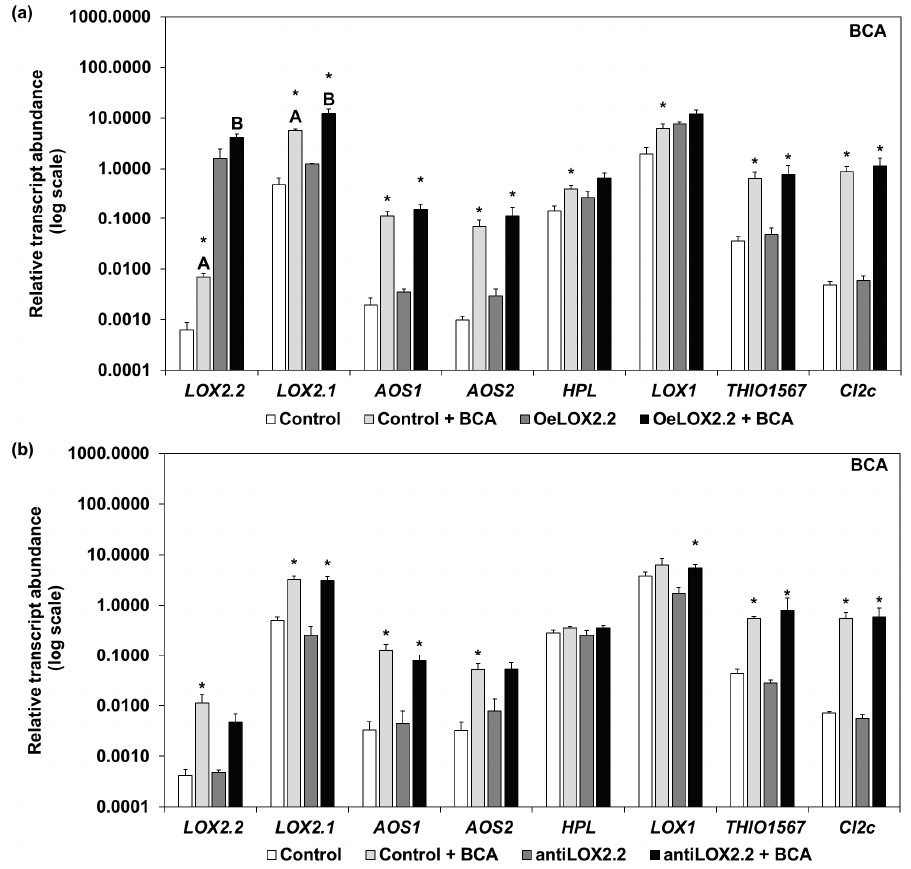
Figure 4. Relative transcript abundance in control and transgenic lines without aphids and infested with BCA for five days. ( a ) Control and OeLOX2.2 plants, ( b ) control and antiLOX2.2 plants. White and light grey bars represent control plants, with and without aphids; dark grey and black bars represent transgenic lines with and without aphids. The transcript abundance is relative to reference genes Hsp70 and Tubulin (±SE). Different letters indicate significant differences between the infested lines, asterisks indicate significant differences for the same line with and without BCA (* p < 0.05 Mann-Whitney test; n = 3 for plants without aphids, n = 4 for infested plants; three technical replicates).